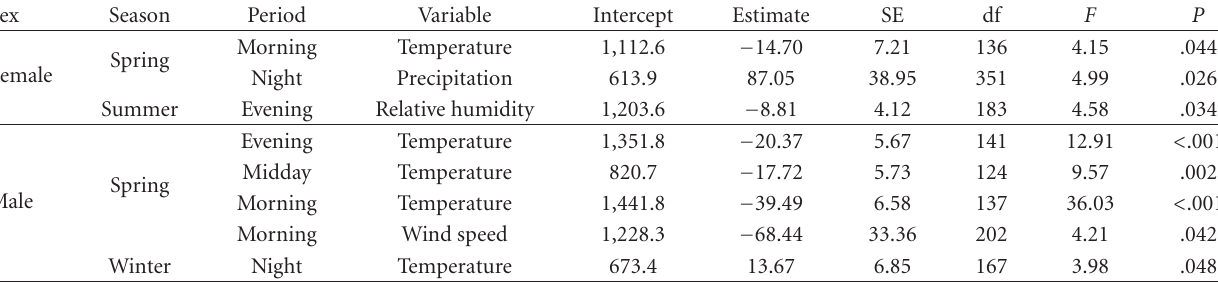
Table 2: Linear relationships between weather variables and female and male white-tailed deer movements across seasons and time periods. Sex Season Period Variable Intercept Estimate Morning Temperature Spring Female Evening Spring